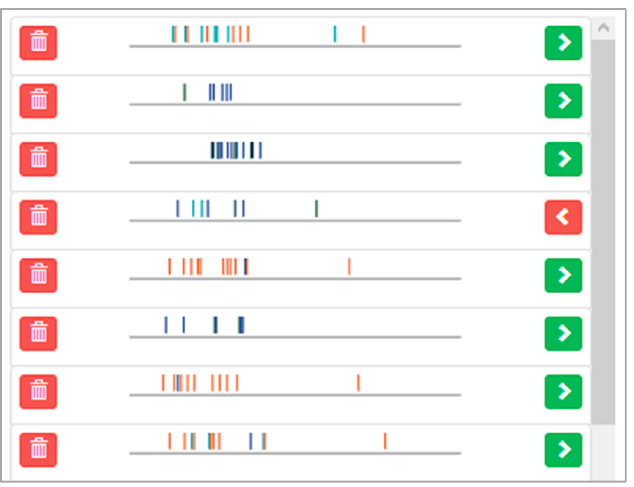
Figure 14. A closer view of the Selected Documents listing, where the user can see timeline-like abstraction of documents and their alignment with the search formulation.